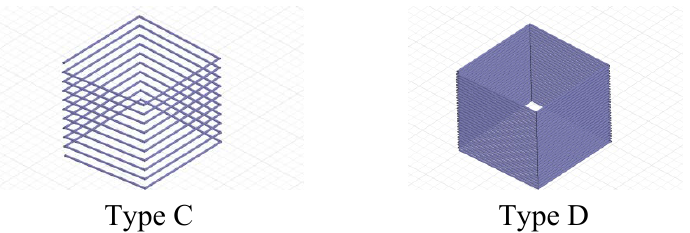
Figure 18. The coils made of enamel-covered